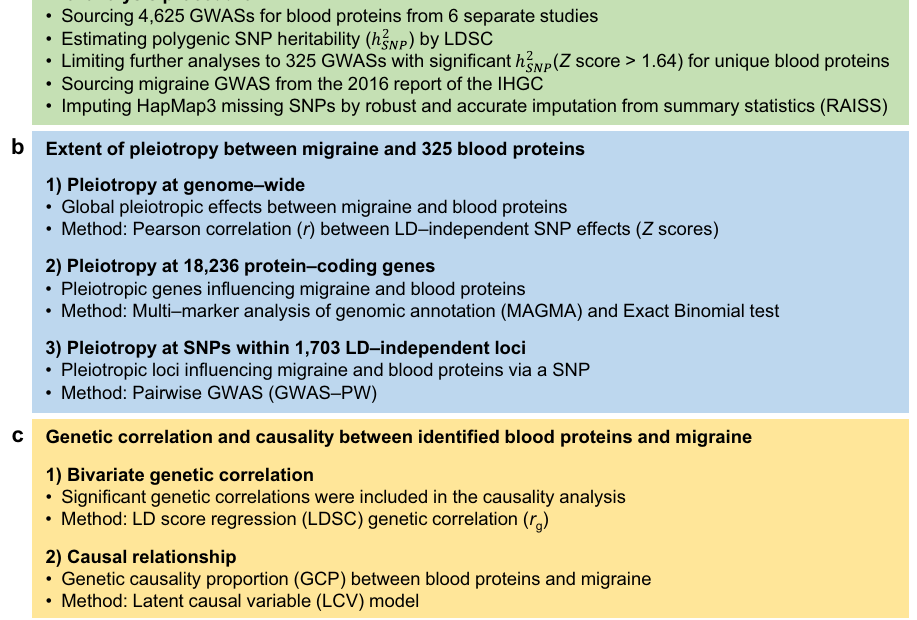
migraine-associated genes are enriched in the genes in fl uencing blood levels of 15 proteins at FDR ≤ 0.05 (Fig. 2b). We recently suggested that a signi fi cant enrichment of associated genes (bio- logically meaningful units) for two traits, here migraine and a blood protein level, provides insights into a shared biological mechanism underlying two traits known as biological or hor- (RBBP5, P binomial-test = 4 × 10 – 21 ). Our original MAGMA result from migraine GWAS suggested 494 genes associated with migraine risk at P gene ≤ 0.05/18,236 (Supplementary Fig. 1a and Supplementary Data 3). To identify